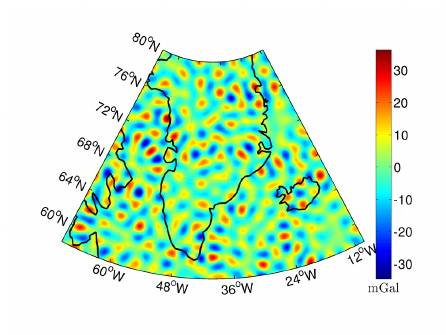
Fig. 8. Gravity anomaly change between November 2009 and June 2010 observed using GOCE T ZZ